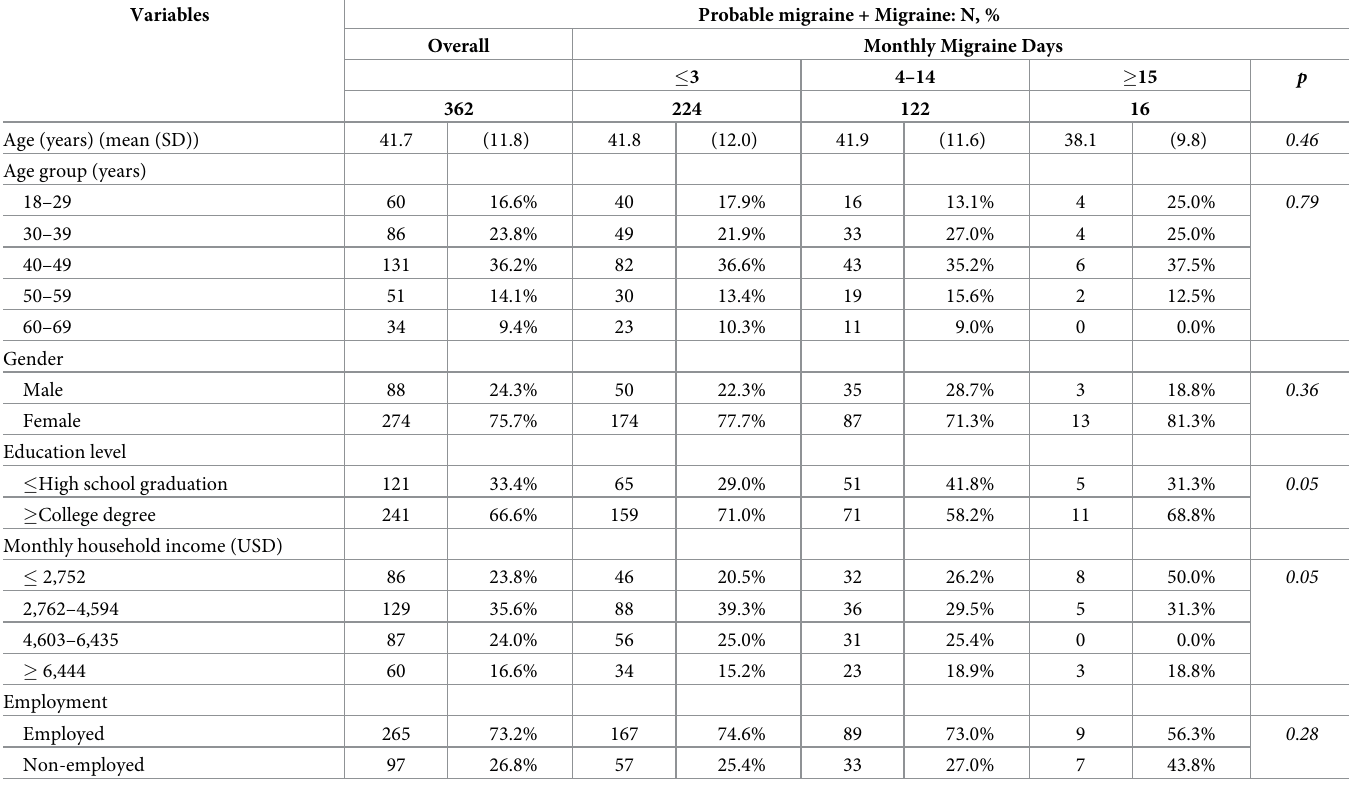
Table 1. Demographics of the MMD